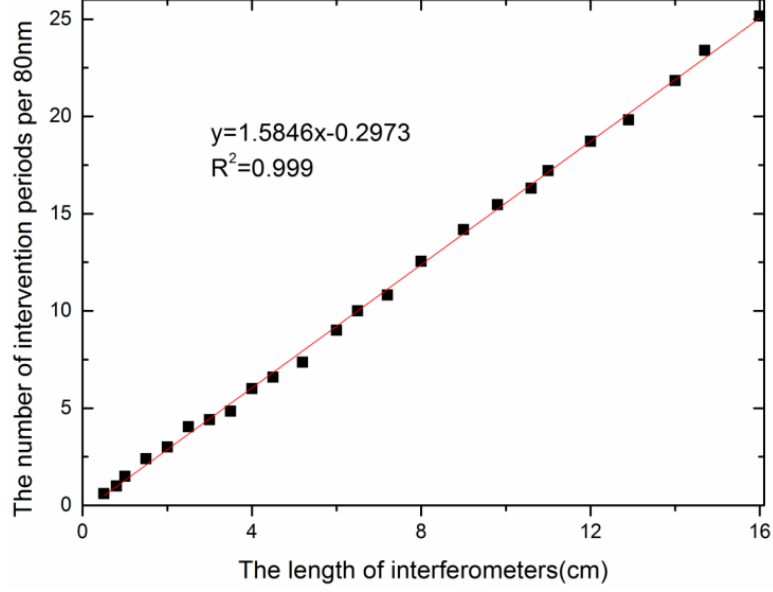
Figure 3. The relationship between the number of intervention periods and the length of sensing arm.